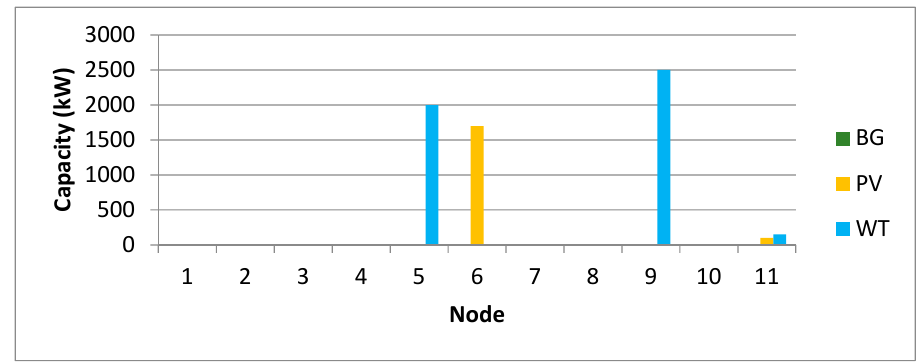
Figure A1. Capacity structure for 30% share of energy from RES in total demand with sizing and allocation of RES only.